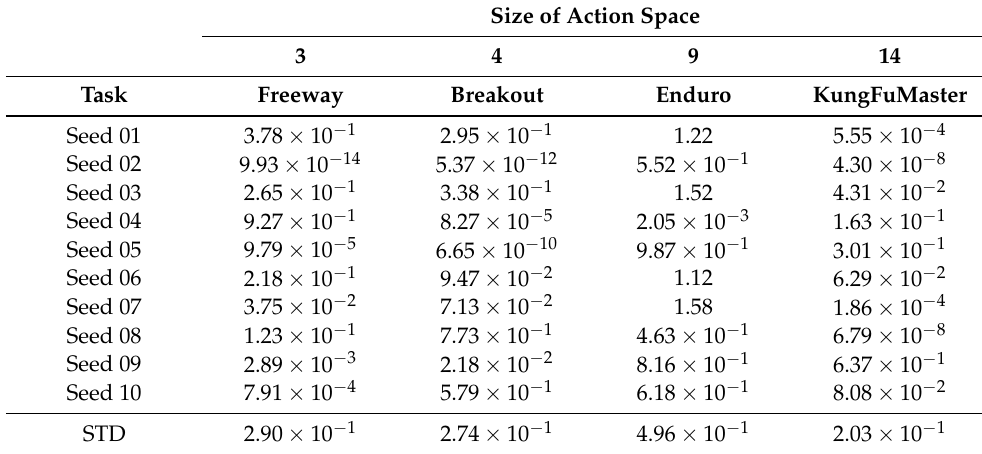
Table 2. Initial entropy of Freeway, Breakout, Enduro, and KungFuMaster under different random seeds, where “STD” denotes the standard deviation of the initial entropy values for 10 different random